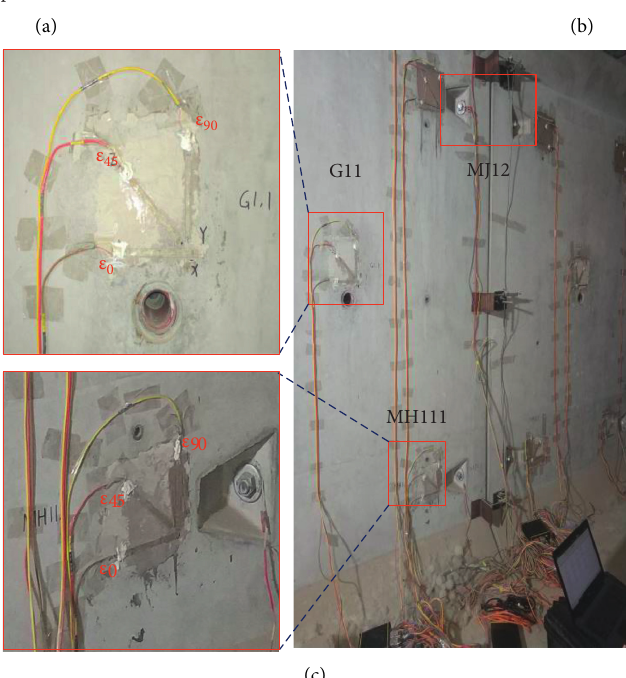
Figure 2: Monitoring point layout. (a) Side view of the measuring point inside the tunnel. (b) Top view of the measuring point inside the tunnel. (c) Strain flower in the UUT for monitoring